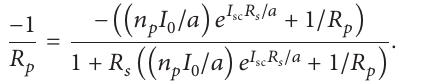
Figure 2: Equivalent circuit of one-diode model for a solar